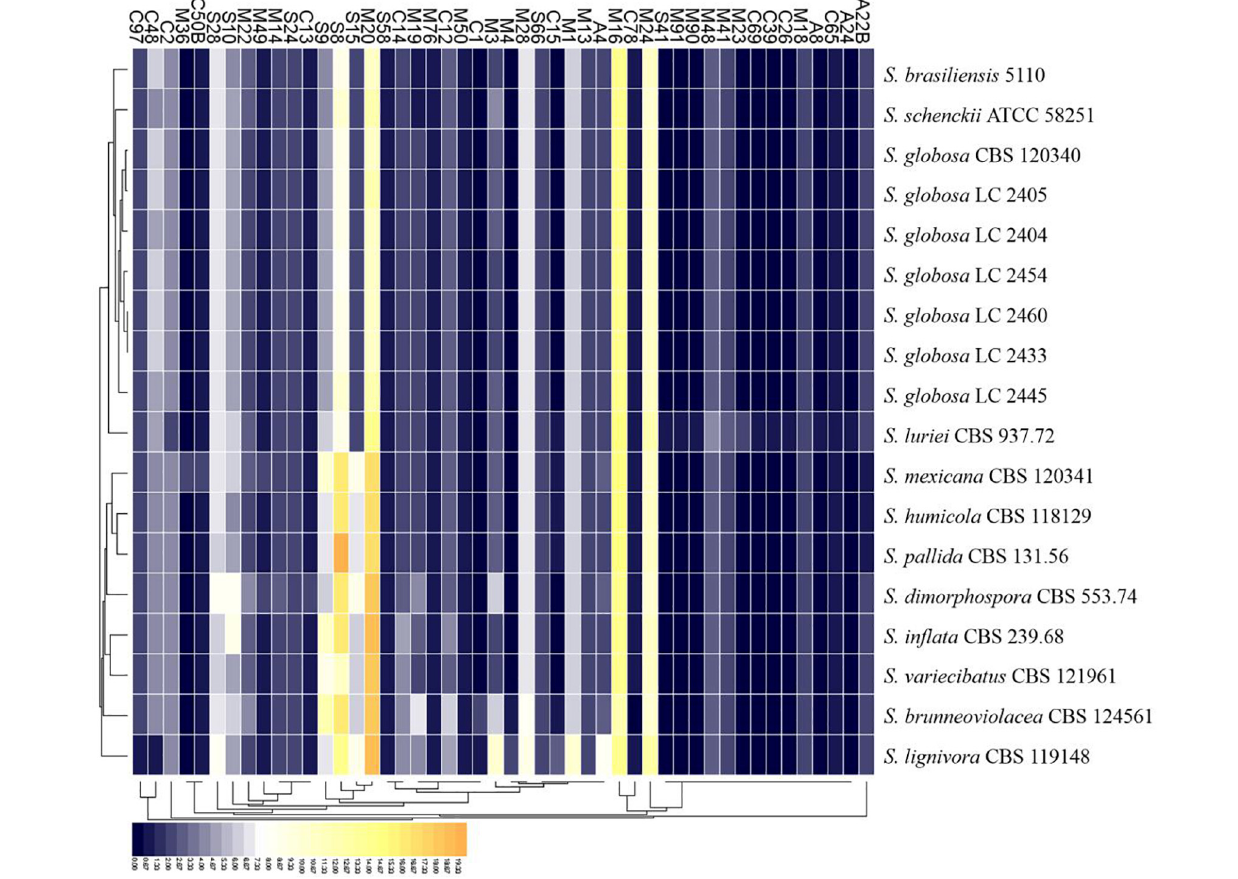
FIGURE 7 | Heatmap of the peptidases identified in the genomes of the genus Sporothrix. Protease-coding genes of Sporothrix identified through Pfam database were classified into 48 subfamilies. The four main clinical species ( S. brasiliensis , S. schenckii , S. globosa, and S. luriei ) had less M20, S8, S9, and S15 subfamily genes than other